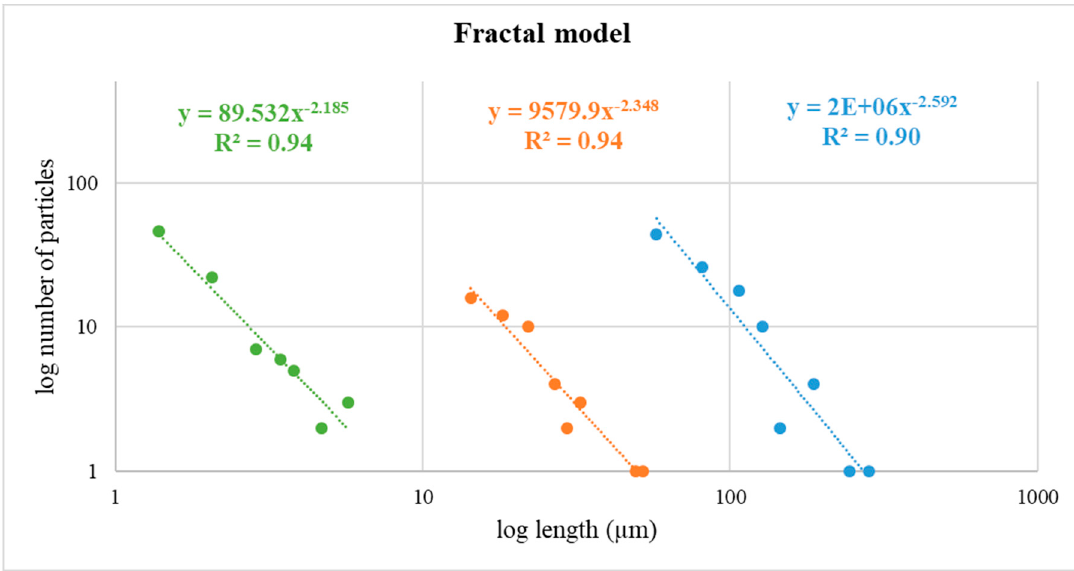
Figure 7. Chart showing the power-law fitting of the experimental data points obtained at magnifications of 10 2 × (blue circles), 10 3 × (orange squares), and 10 4 × (green triangles).